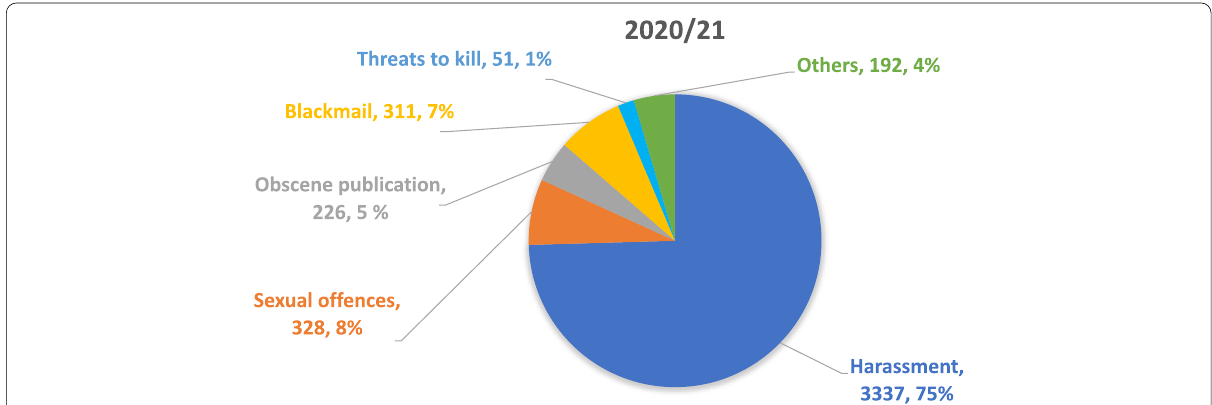
Fig. 3 Number and percentage of online crime by type of offenses,